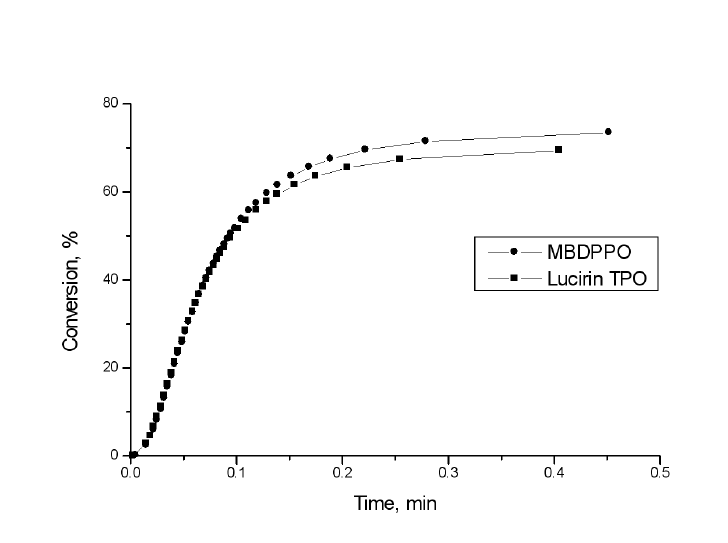
Fig. 3 Conversion of HDDA using MBDPPO and Lucirin TPO as photoinitiator (conc. 3 % w/w), in the presence of 3 % w/w triethylamine at 30 ◦